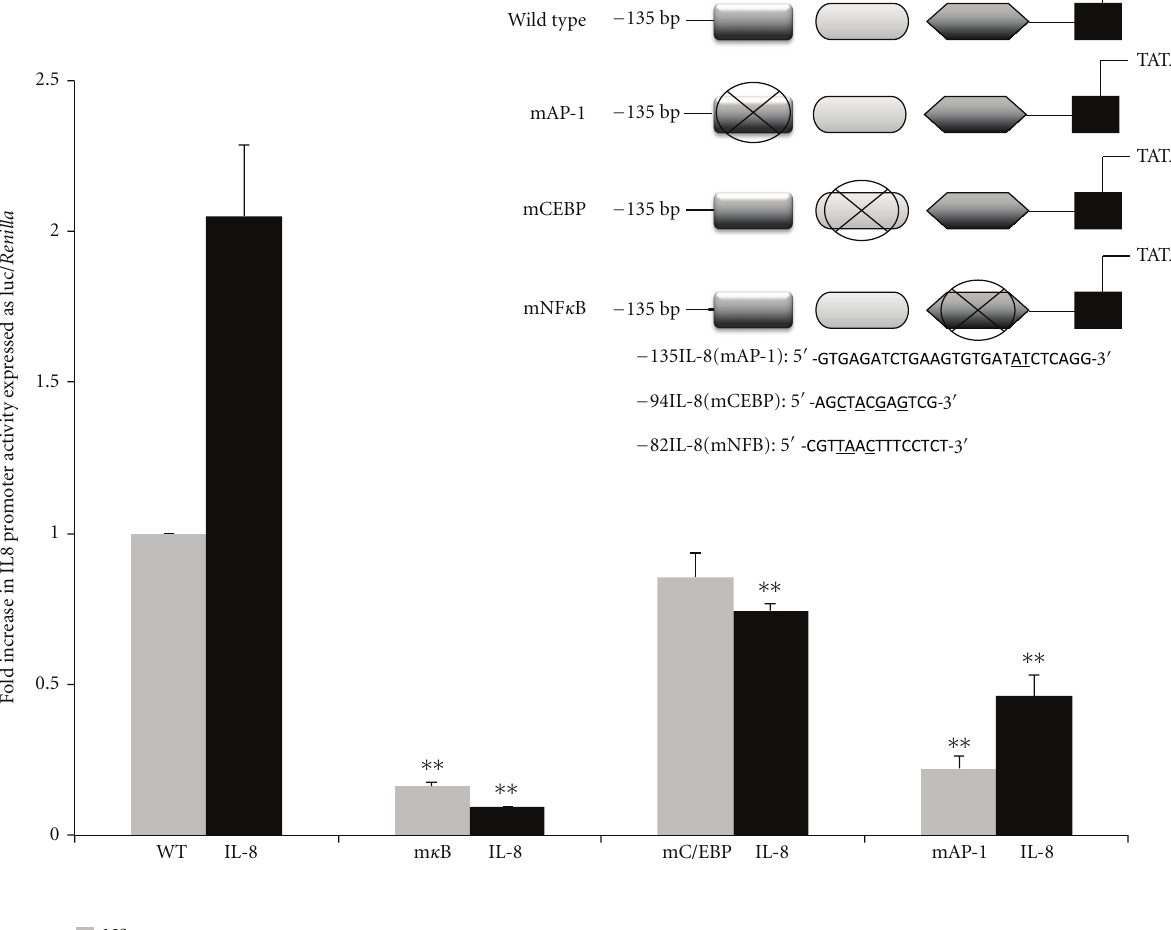
Figure 2: Representation of the IL8 promoter region and the mutations used in this study, as indicated by the underlined nucleotides. mAP- 1: mutation of AP-1. mNF κ B: mutation of NF κ B and mCEBP: mutation of CEBP binding site. Functional e ff ect of site-directed mutagenesis of transcription factor binding sites in the IL8 promoter in primary human myometrial cells. Data are presented as mean ± SEM ( n = 4). An Anova test was performed with a Dunnett’s multiple comparison post-test. ∗∗ indicates a significant di ff erence of P less than 0.01 compared to WT